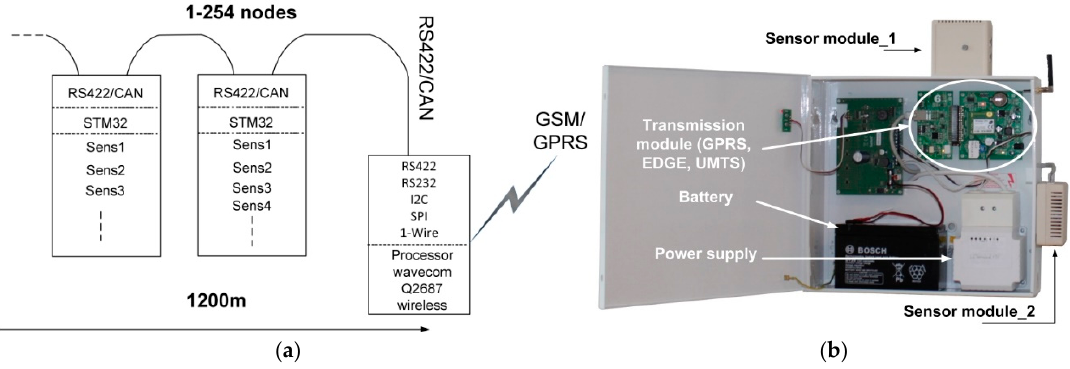
Figure 3. A ModBus network concentrator module: ( a ) a schematic view of transmission chain; and ( b ) a photo of a real concentrator including power supply.